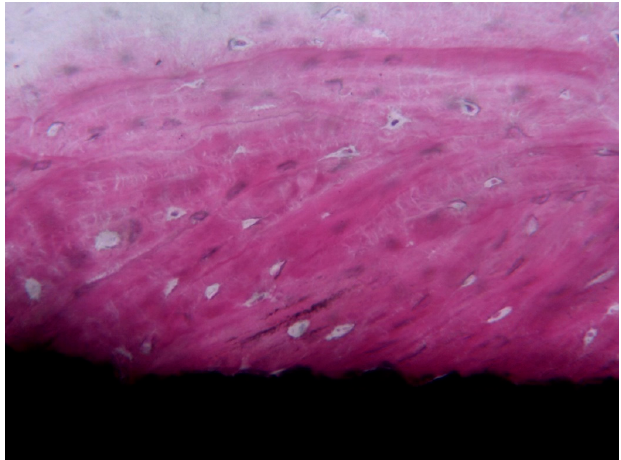
Figure 7. At higher magnification, many osteocytes were observed at the level of peri-implant bone, close to the implant surface. Implant was retrieved for abutment fracture after 7 years of service. The implant supported a bridge. Courtesy of Dr. Marco Degidi (toluidine blue and acid fuchsin staining, magnification 200×).